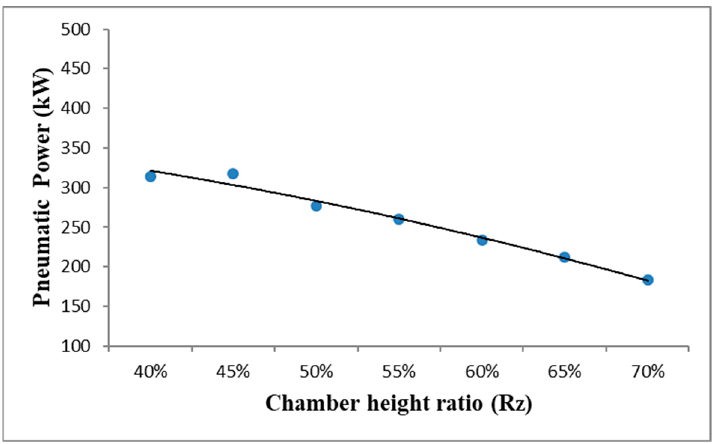
Figure 20. Pneumatic power corresponding to height-ratio R Z of OWC chamber.